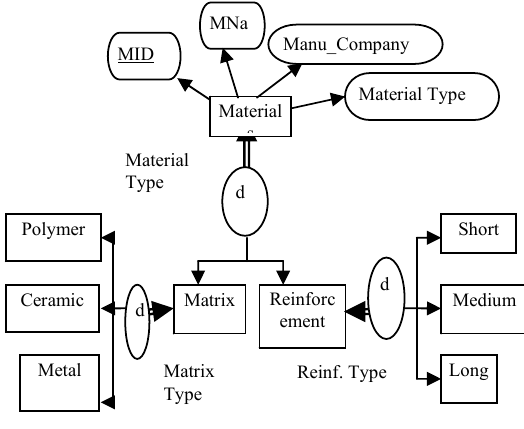
Figure 2: Cardinality and Disjoint Constraints in specialization